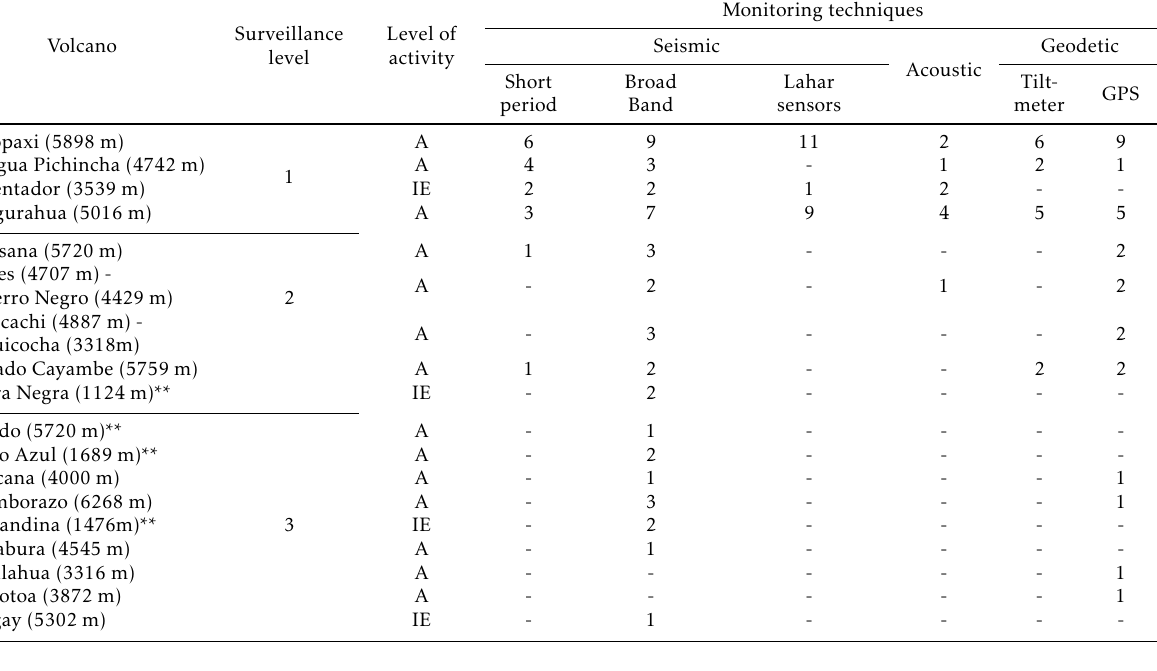
Table 1: Monitoring techniques used by the IG-EPN for the surveillance of 20 volcanoes in Ecuador; 16 in mainland and 4 in the Galápagos Islands. Volcanoes are grouped depending on the surveillance level. A = Active; E = Extinct; IE = In